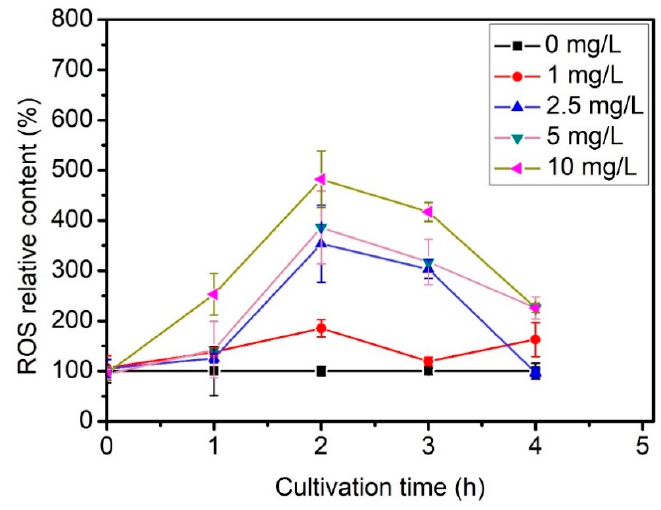
Figure 7. Intracellular ROS induced by MoZnO in the M. aeruginosa cells.